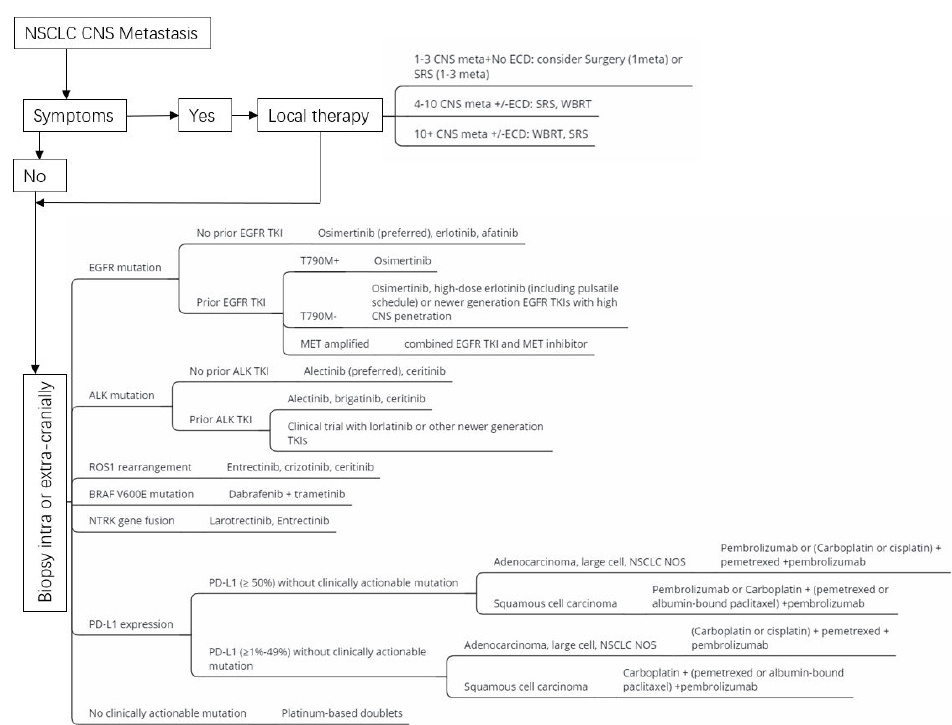
Figure 1. Treatment algorithm for NSCLC CNS